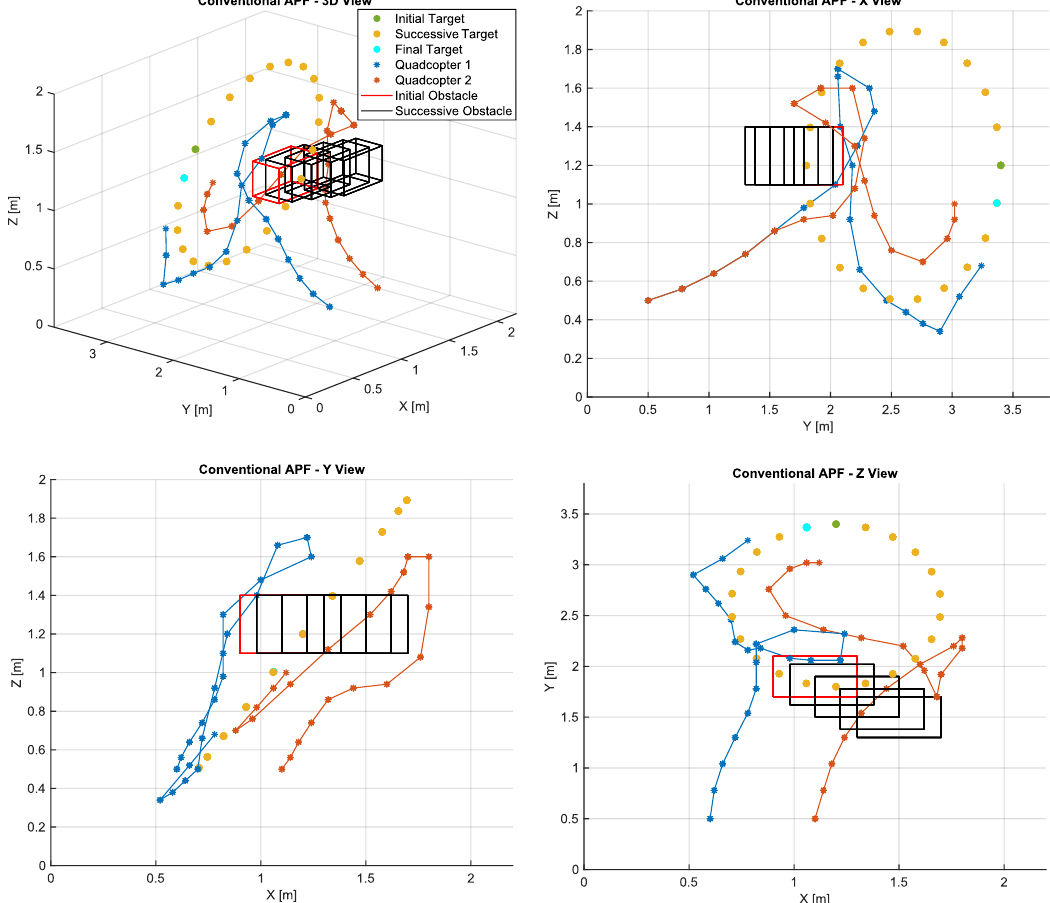
Figure 5. Paths calculated by the conventional APF algorithm.